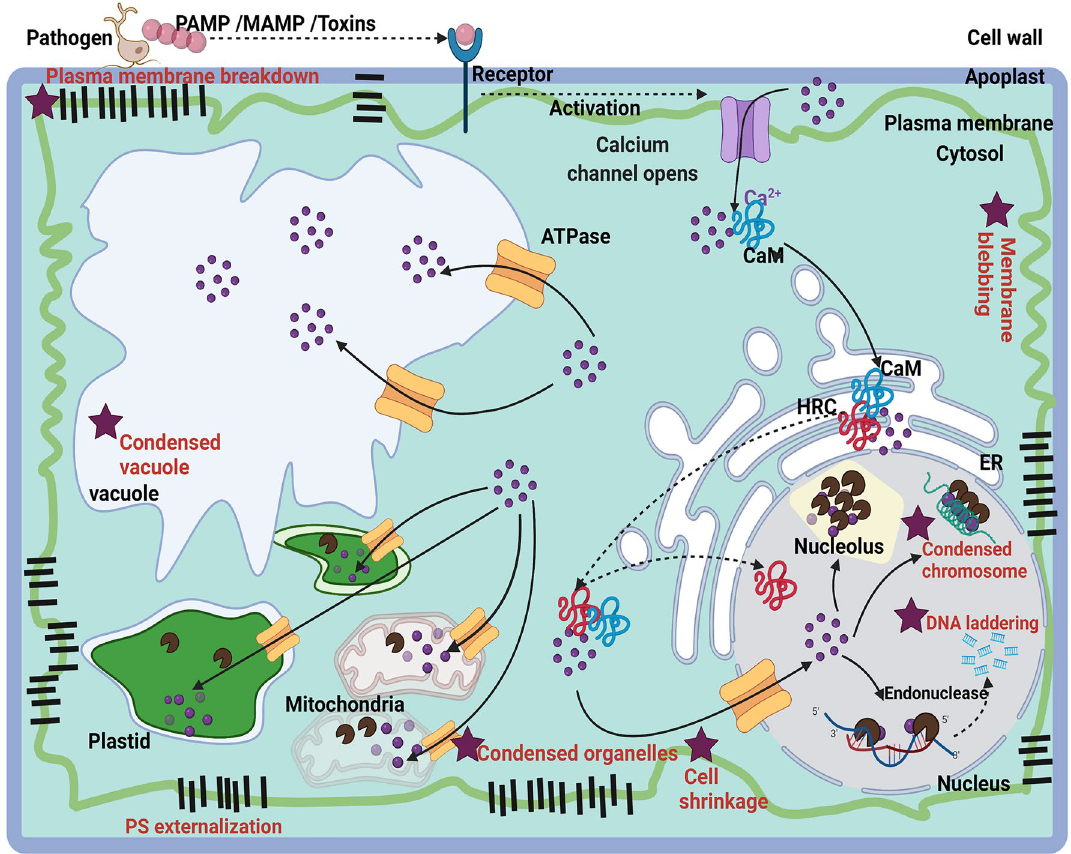
Figure 5. Model for Apoptotic-like PCD (AL-PCD) in plants. The important characteristics of AL-PCD are shown with *: cytoplasm shrinkage, plasma membrane blebbing and breakdown, phosphotidylsterine (PS) externalization, condensed vacuole, plastids and chromosome, and DNA laddering (metacaspases are involved in all thus not shown). Acronyms: Ca 2+ Calcium ions influx through calcium channels; Ca 2+ transport by ATPases; CaM, Calmodulin binding protein; ER, endoplasmic reticulum; HRC, histidine rich calcium binding protein; PAMP/MAMP, pathogen or microbe associated molecular